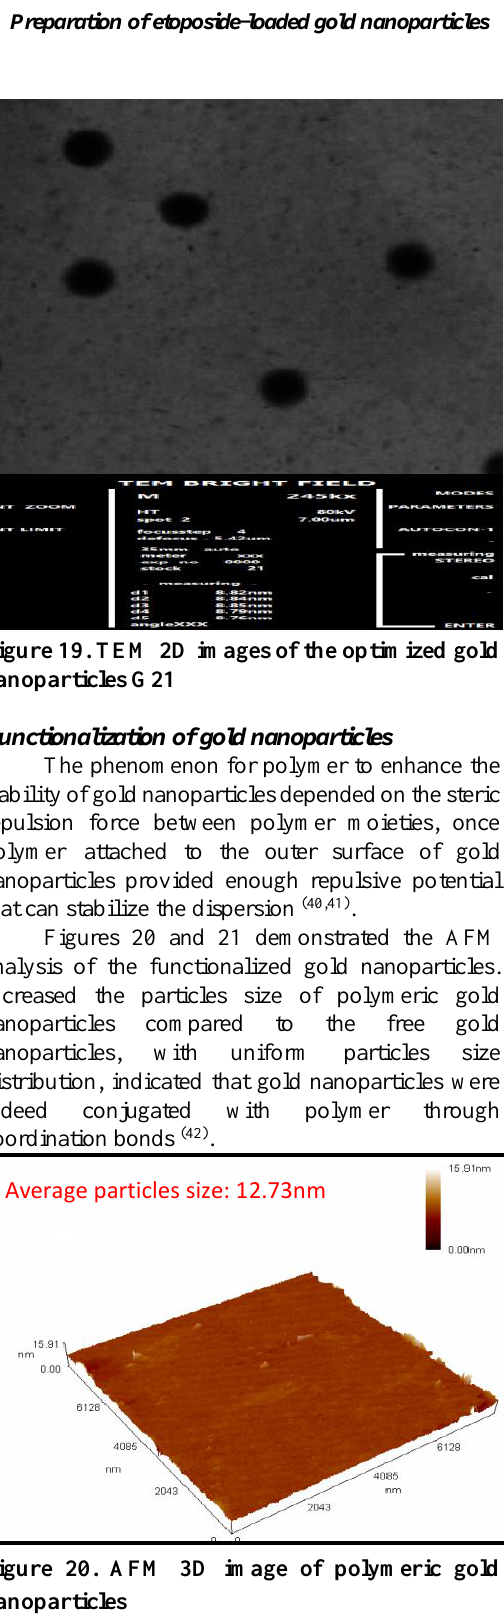
Figure 20. AFM 3D image of polymeric gold nanoparticles